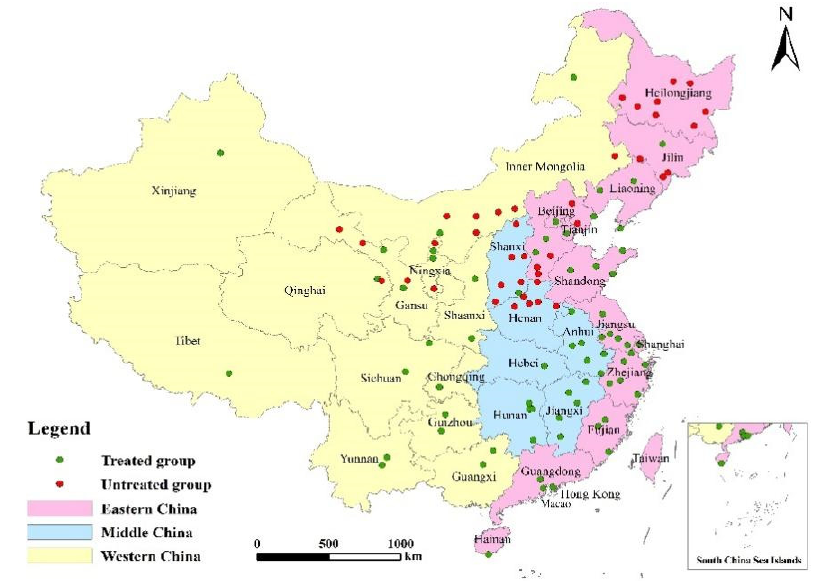
Figure 1. Geographical location map.